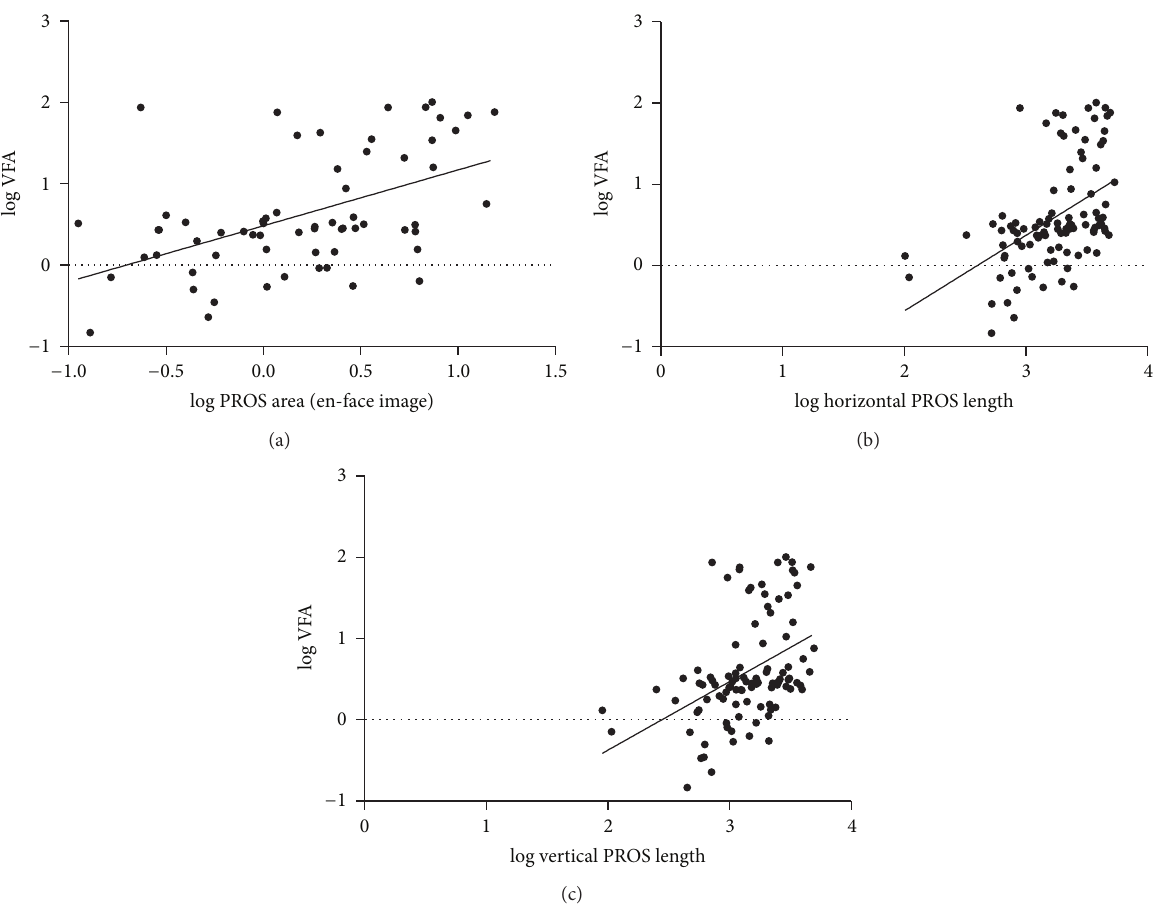
Figure 3: Scatter plot showing the relationships between the log PROS area (en-face image) and log visual field area (a), between the log horizontal PROS length and log visual field area (b), and between the log vertical PROS length and log visual field area. Solid line: the prediction of a linear model.